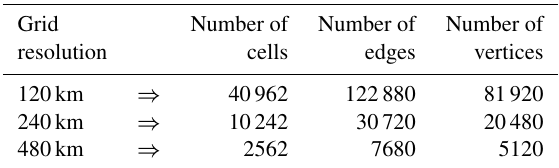
Table 3. Data corresponding to the three SCVT meshes used in the Test Case 5